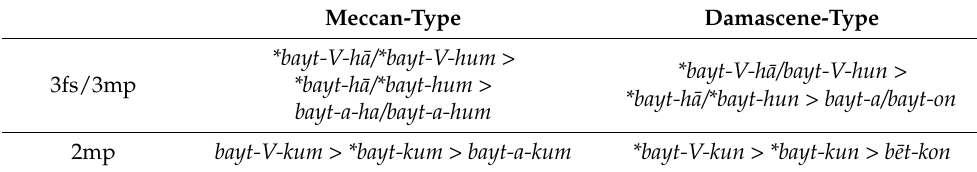
Table 6. Reconstruction of Meccan and Damascene.